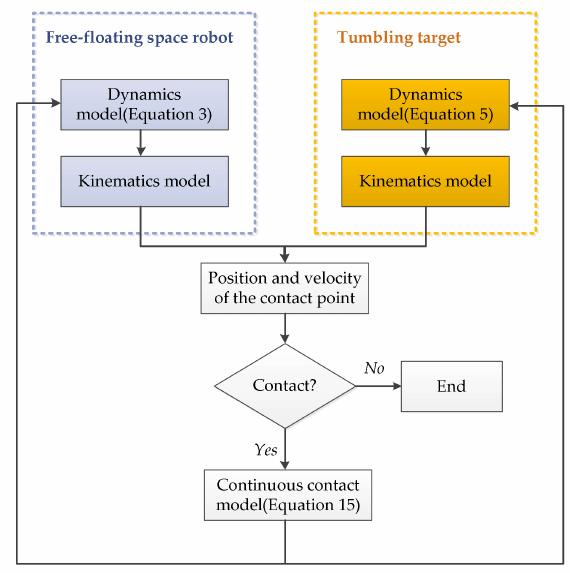
Figure 2. Classical numerical integration method for contact force